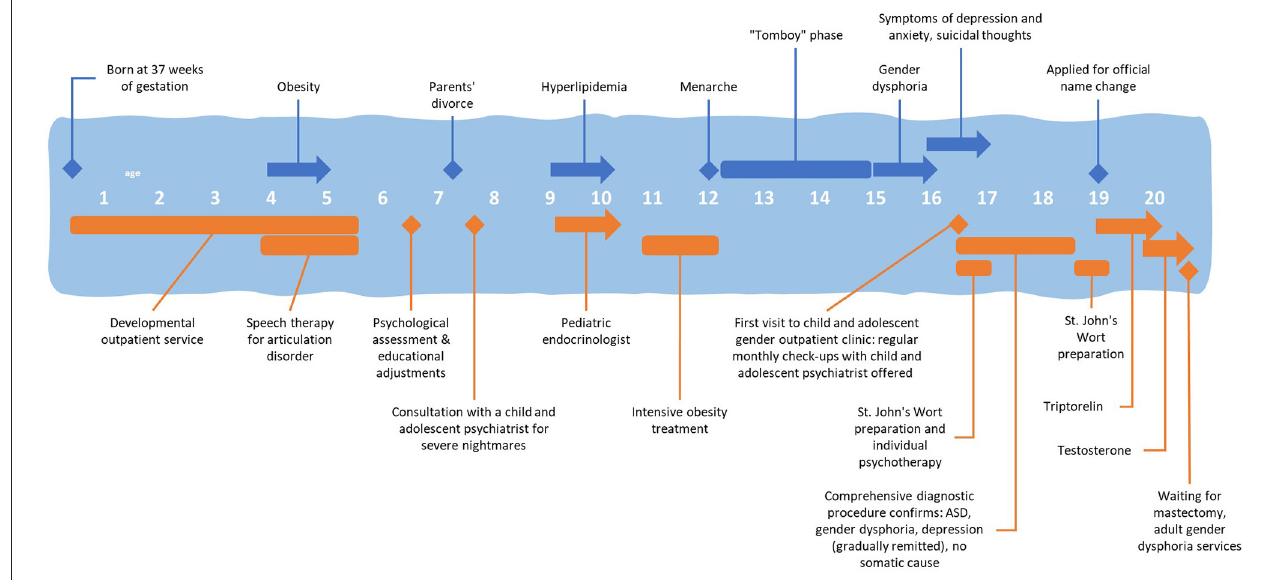
FIGURE 1 | Timeline with relevant data from the continued care of an adolescent patient with comorbid ASD and gender dysphoria in the Slovene Child and Adolescent Gender Outpatient